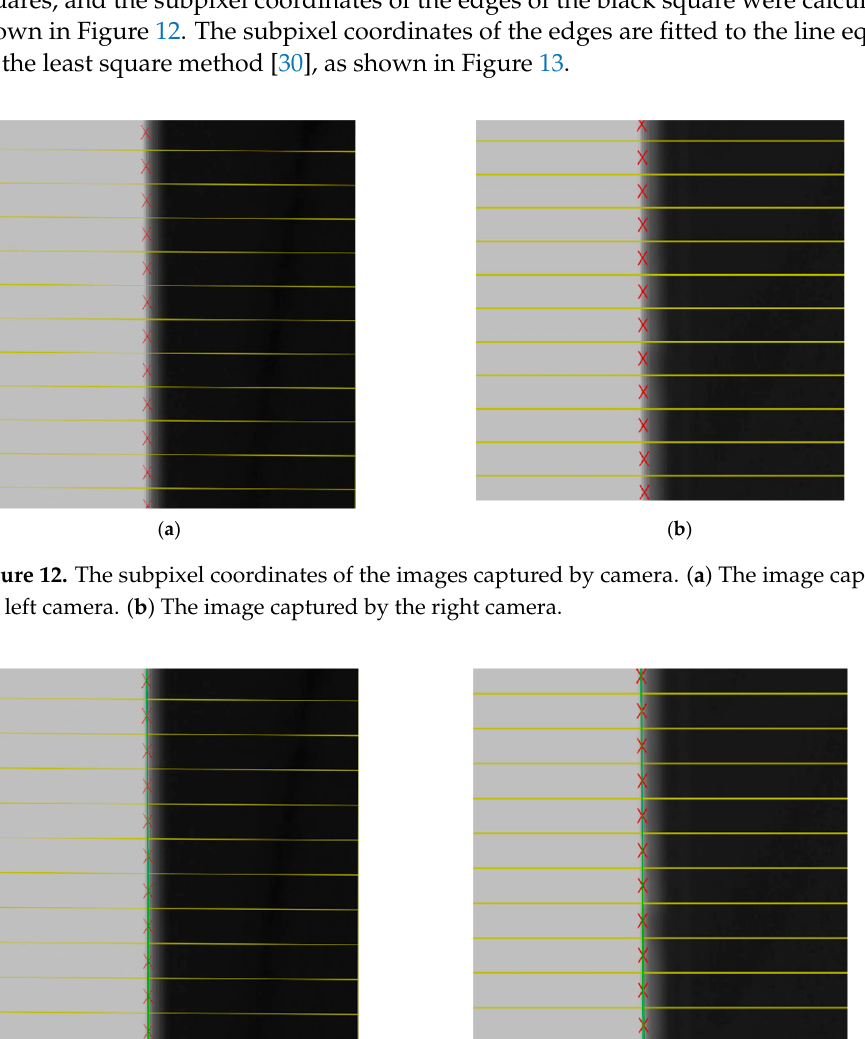
Figure 11. Images captured by the left and right camera. ( a ) The image captured by the left cam- era. ( b ) The image captured by the right camera.